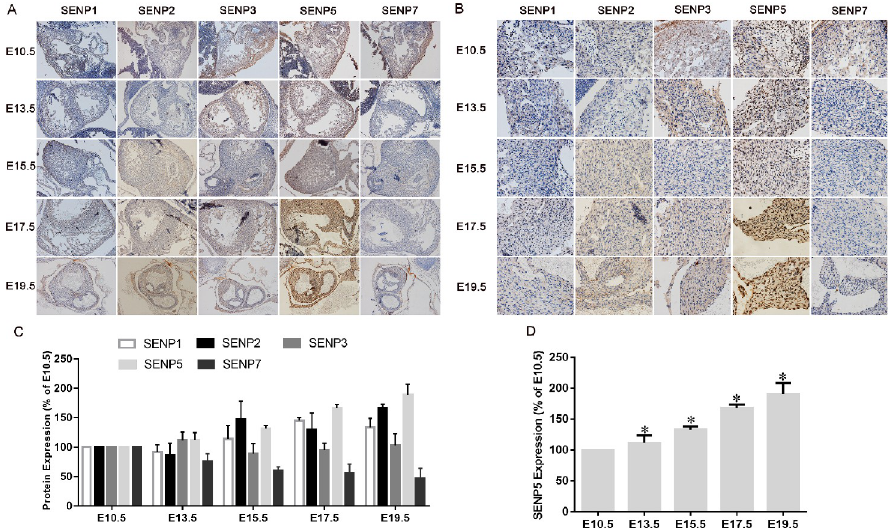
Fig 2. Spatiotemporal distribution characteristics of SENP family members during fetal mouse development. (A) Immunohistochemistry of SENP families expression from E10.5 to E19.5 (n = 4). (B) Enlargements of (A) (n = 4). (C) Relative levels of SENPs expression were quantified from E10.5 to E19.5. (D) Expression levels of SENP5. Statistical significance was analyzed using the t-test. Values are presented as the mean ± SD. Statistical significance was analyzed by the Tukey’s test. � P < 0.05 vs.